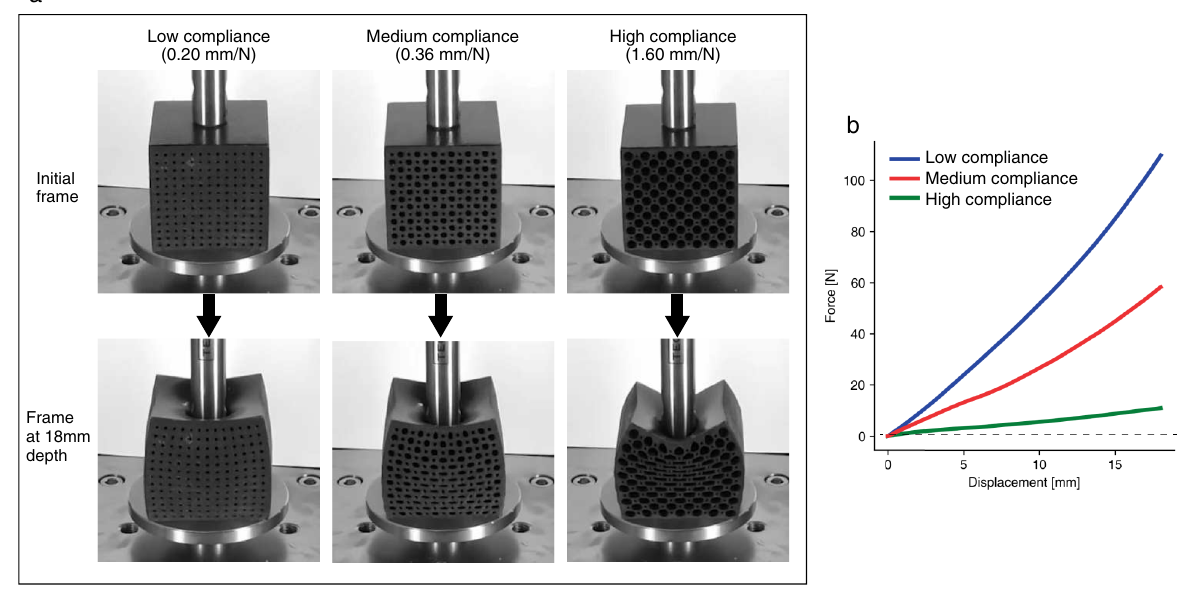
Figure 1. ( a ) Snapshots of video clips for materials with low, medium, and high compliance. The video frames for 0 mm and 18 mm indentation depth are shown for each material. ( b ) Force–displacement curves of three materials.